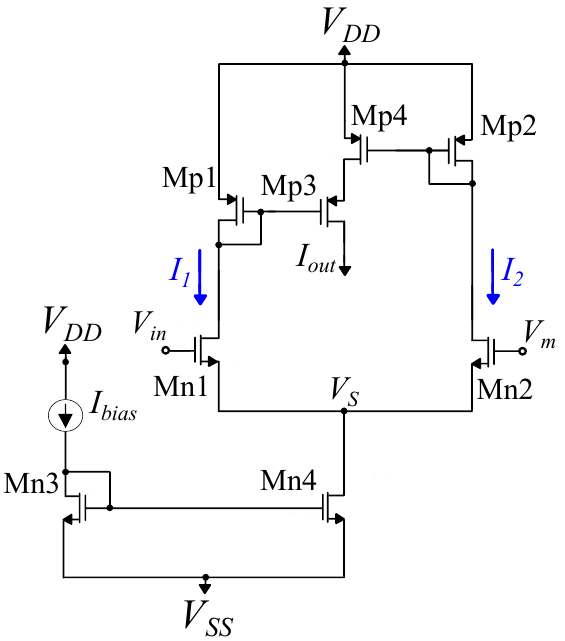
Figure 1. Delbruck’s Simple Bump transistor level implementation.